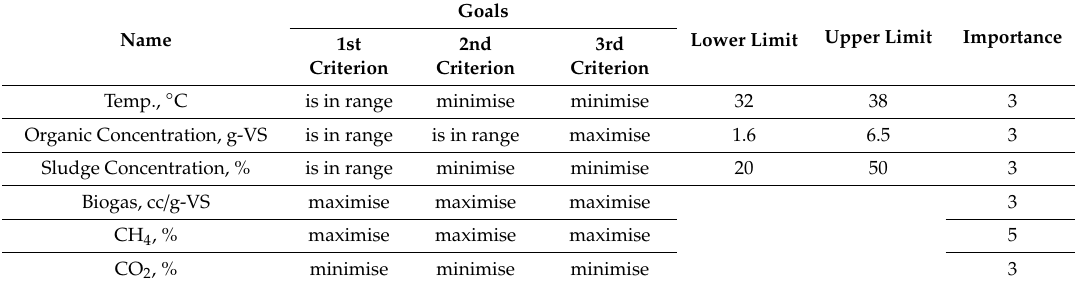
Table 3. Optimisation